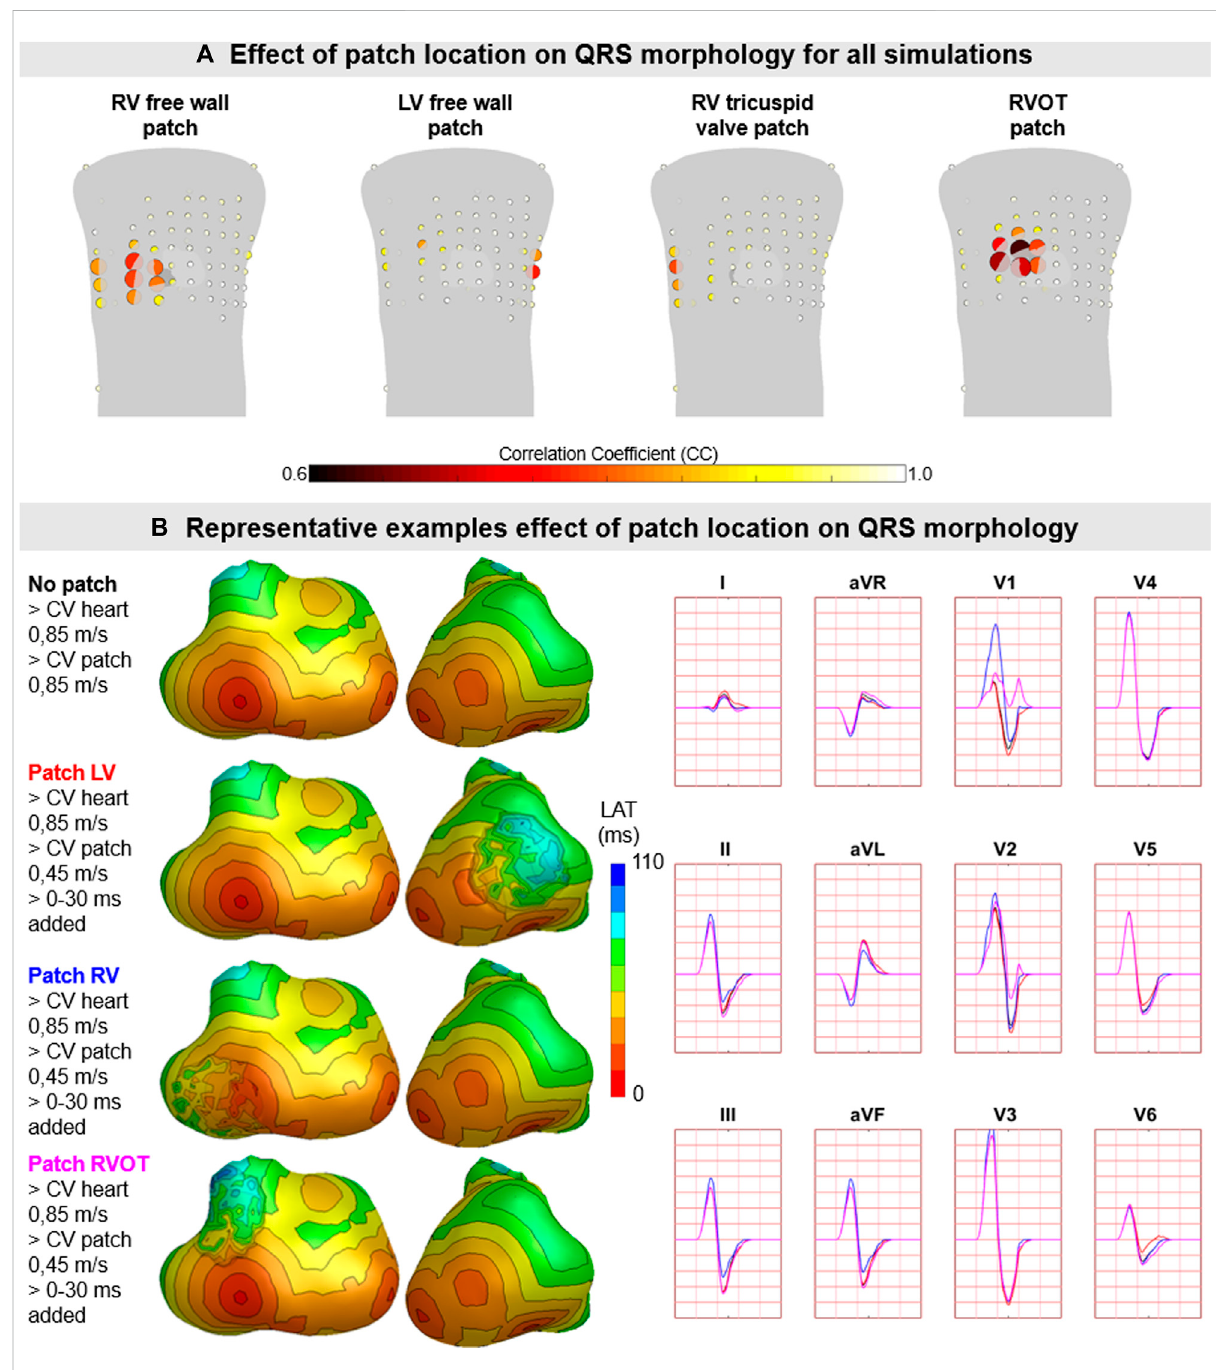
FIGURE 9 Theeffectofpatchlocationonsimulatedbodysurfacepotentials. (A) Themean±standarddeviationofcorrelationcoef fi cient(CC)perBPSlead between normal and diseasedBSP.Eachleadisrepresented byadotwith thecolorrepresenting averageCC(range0.6 – 1)andsize representing the magnitude in standard deviation ofCC. The heart contour(light grey)with patch (dark grey) isdisplayed within the torso. (B) Representative example of the effect of patch location on BSP. Activation sequences of the patches and ventricles are displayed from red (early) to blue (late) with isochronestepsof10 ms.SimulatedBSParedisplayedforthestandard12-leadECG.ThecolorsintheECGcorrespondtothecolorsstatedintheleft column with the simulation characteristics. One cube in the 12-lead ECG corresponds to 40 ms (width) and 0.5 mV